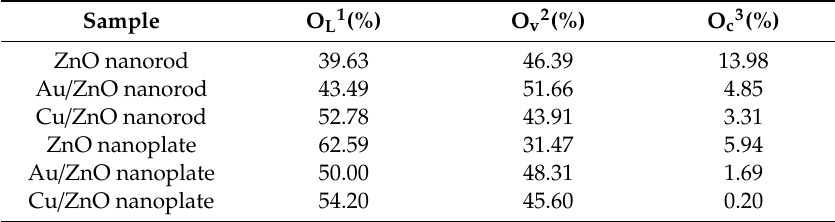
1 lattice oxygen; 2 oxygen around vacancy; 3 chemisorbed